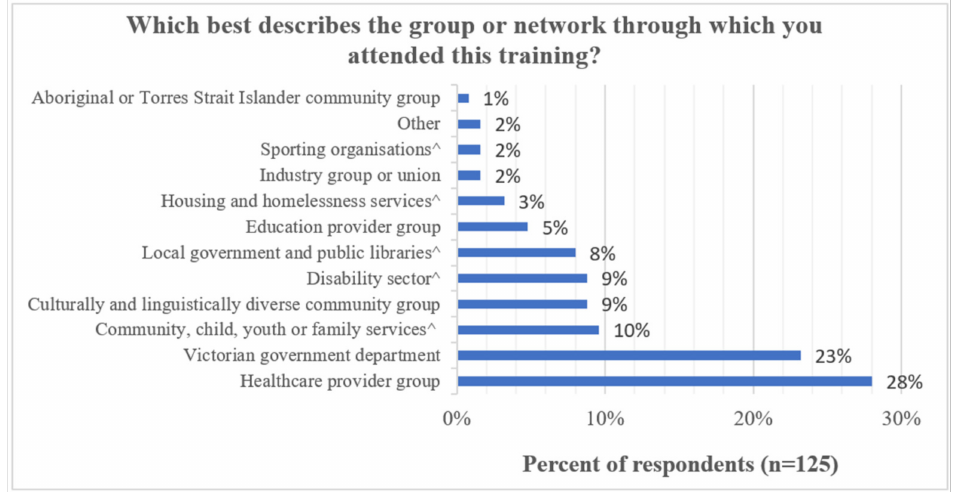
Figure 2. Organizations of session participants. ˆ Categories created based on free text responses to “Other” option.